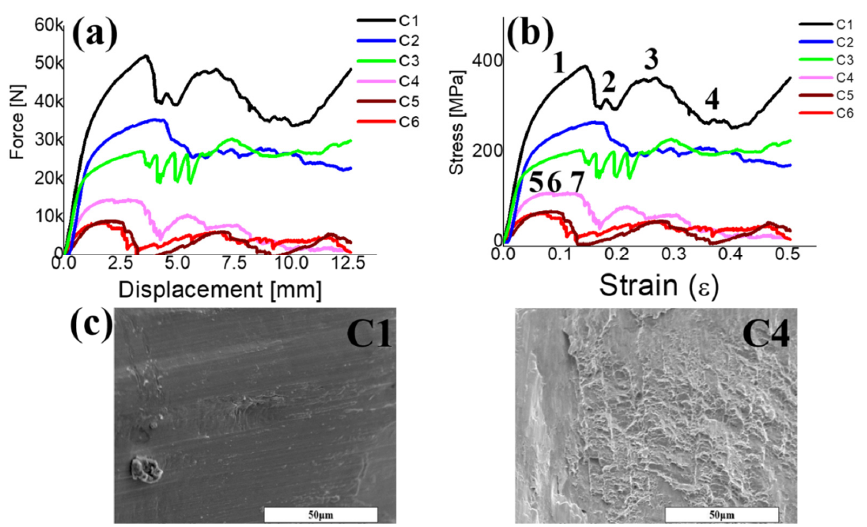
Figure 3. Compressive curves for Ti6Al4V porous specimens with different porosities fabricated by EBAM. The porosities of specimens: C1—25%, C2—33%, C3—40%, C4—55%, C5—59%, and C6—63% in ( a ) force vs. displacement and ( b ) engi- neering stress vs. engineering strain. Before and after elastic deformation with post collapse denoted, respectively, in (1)– (4) and (5)–(7) strain stress curves in the C1 and C4 specimens. Fracture surface in ( c ) shows the smooth surface of C1 and C6—63% in ( a ) force vs. displacement and ( b ) engineering stress vs. engineering strain. Before the ductile dimples of C6 specimen.